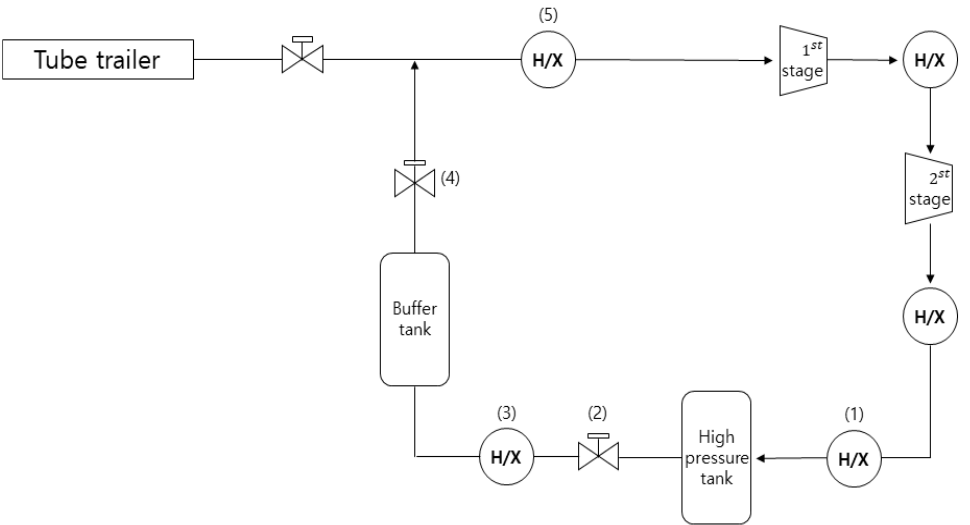
Figure 1. The schematic diagram of the hydrogen station system.